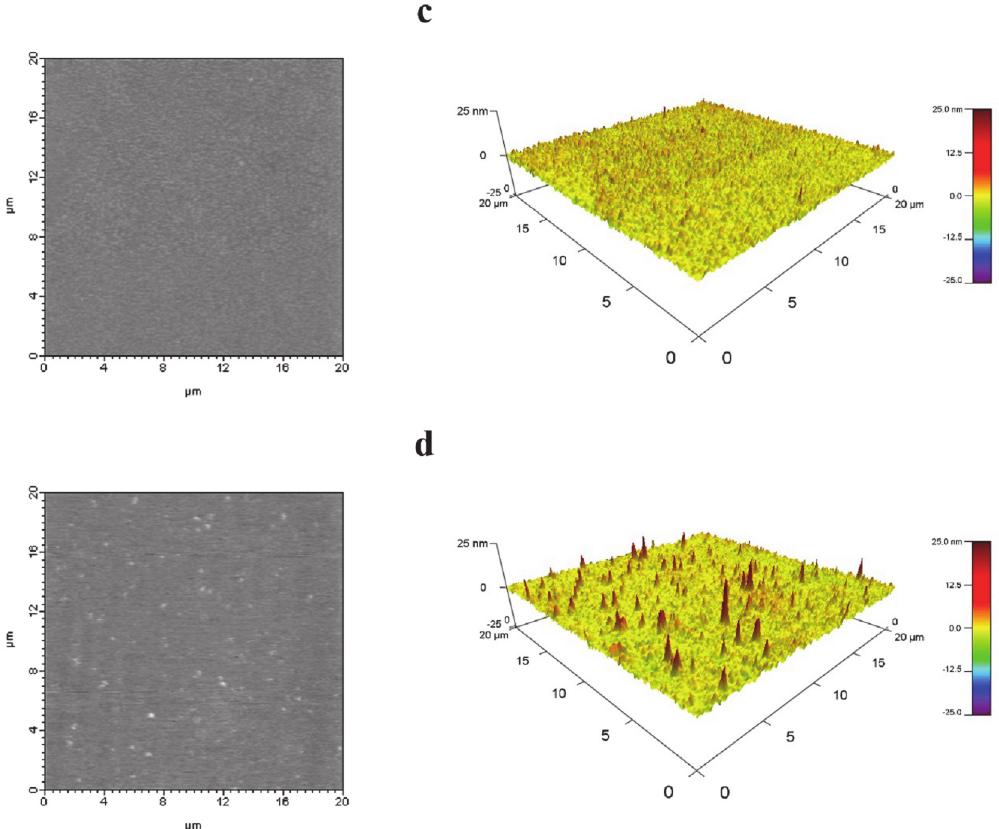
Fig 3. AFM pictures of Sensor CM5 chip surface and surface immobilized with EGFR. (a) The height image of chip. (b) The height image of EGFR immobilized chip. (c)(d) The three-dimensional view of (a) and (b) with a pseudocolor scale ranging from low (purple) to high (red).